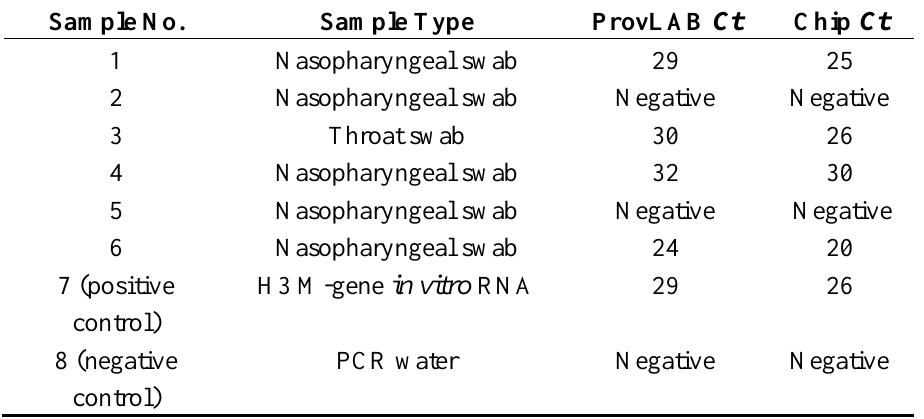
Table 2. Details of the influenza A clinical panel exploited during the multiplex qPCR assay. Sample